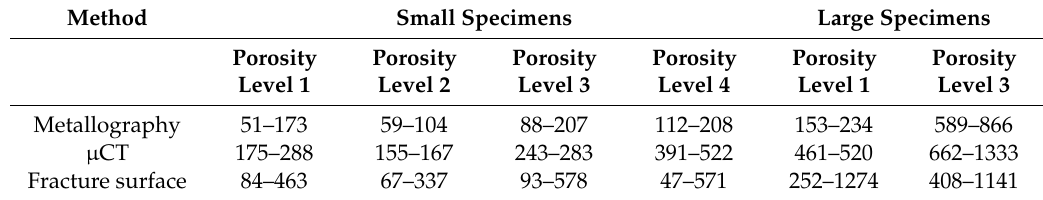
Table 2. Comparison of observed maximum defect size in di ff erent porosity levels (the measurements are in µ m). Method Small Specimens Large Specimens Porosity Porosity Porosity Porosity Porosity Level 1 Level 2 Level 3 Level 4 Level 1